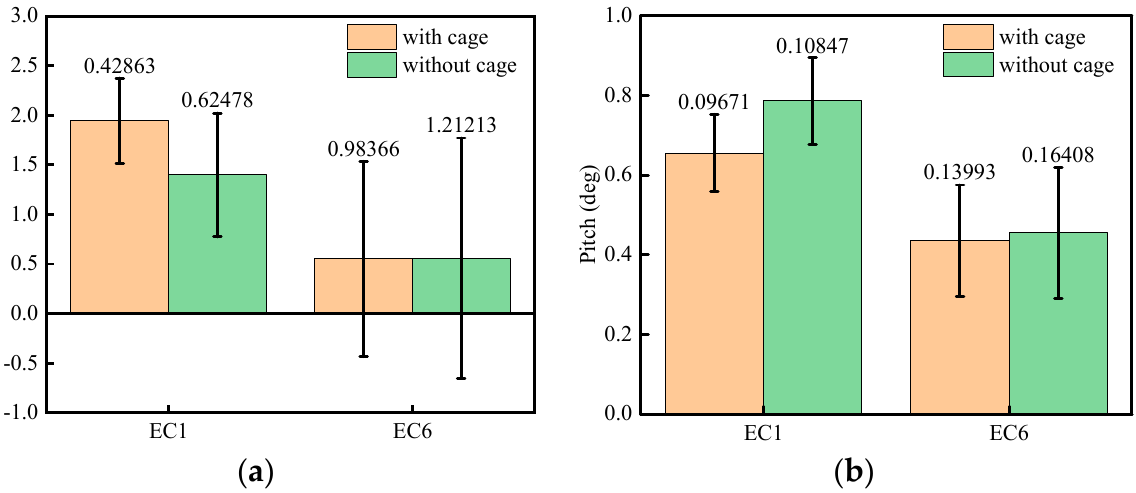
Figure 17. Comparison of motions for the barge-type FOWT-AC and barge-type FOWT in the presence or absence of currents: ( a ) Mean and standard deviation of surge; ( b ) Mean and standard deviation of pitch.